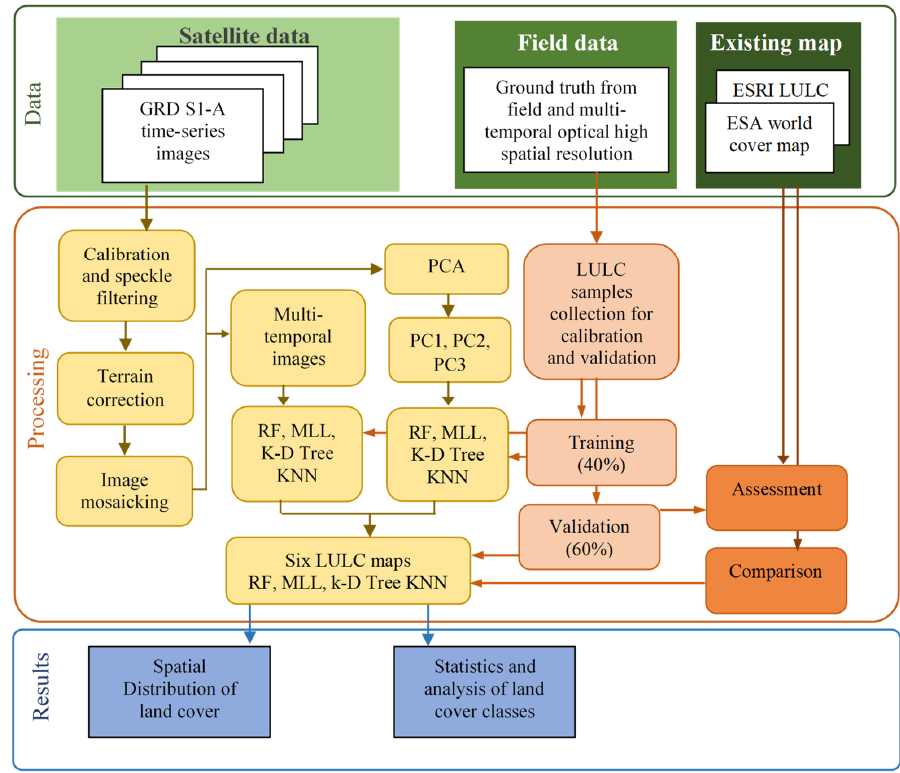
Figure 2. Flowchart showing the technical approach used to evaluate agricultural LULC mapping using S-1 data.